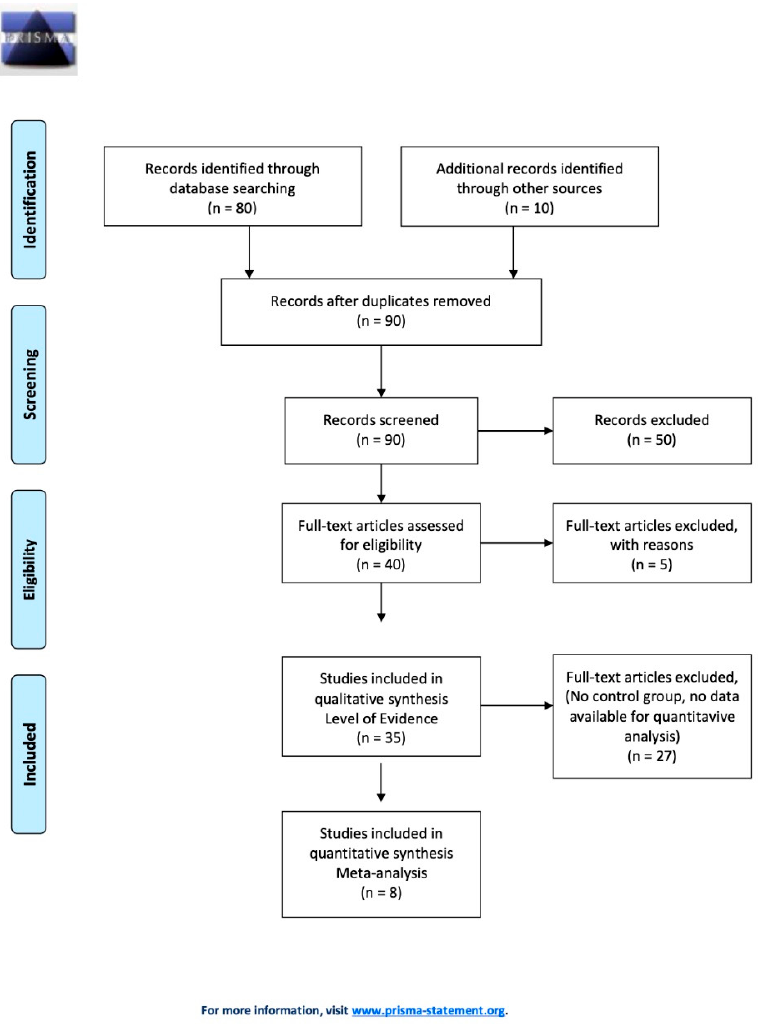
Figure 1. Study selection flow chart.